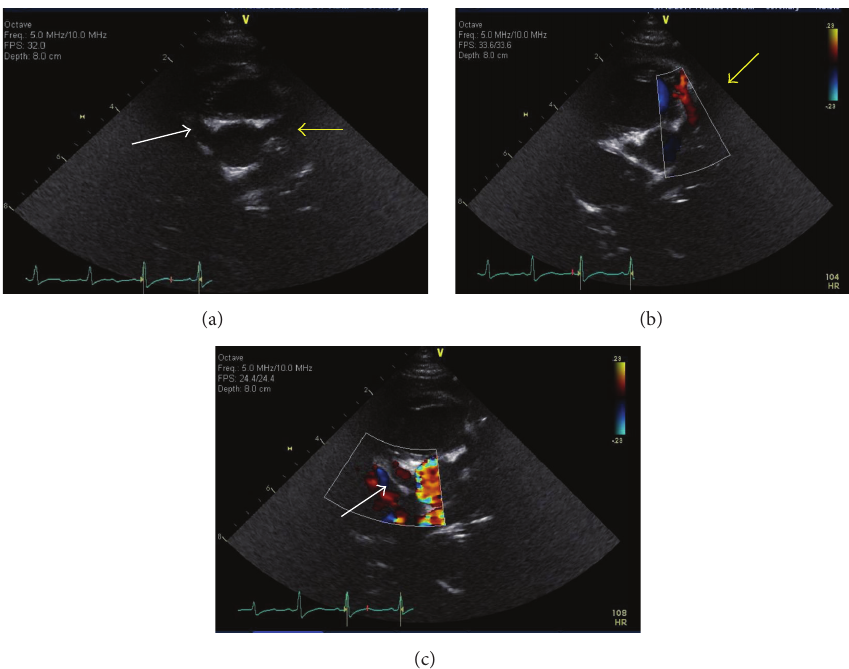
Figure 3: Presurgical transthoracic echocardiographic images of the right and left coronary arteries. (a) 2D transthoracic echocardiographic coronary images prior to cardiac surgery demonstrate dilated proximal right coronary artery (white arrow) and left main coronary artery (yellow arrow). (b) 2D and color Doppler transthoracic image of the dilated left main and left anterior descending coronary arteries (yellow arrow). (c) 2D and color Doppler transthoracic image of the dilated right coronary artery (white arrow).